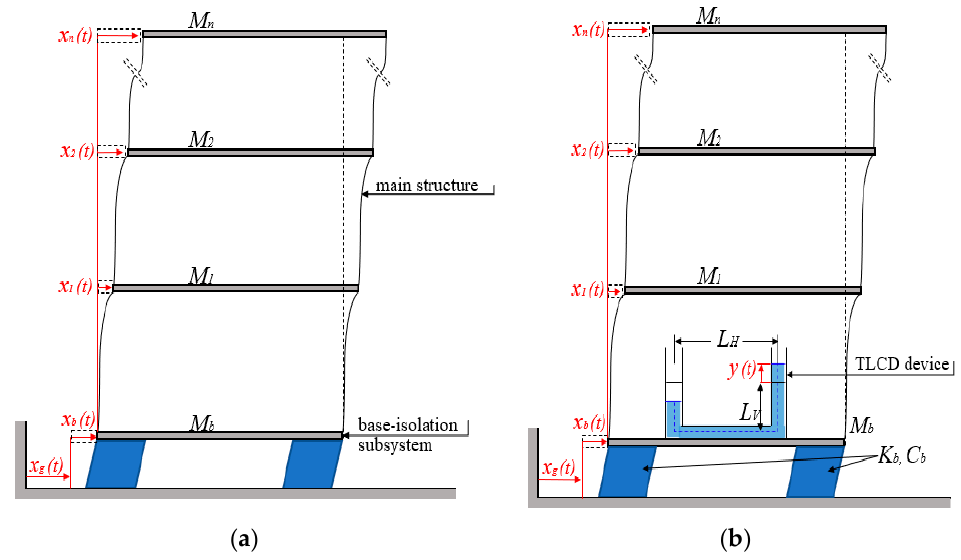
Figure 2. Base-isolated MDOF shear-type frame structures: ( a ) without TLCD; ( b ) with TLCD.